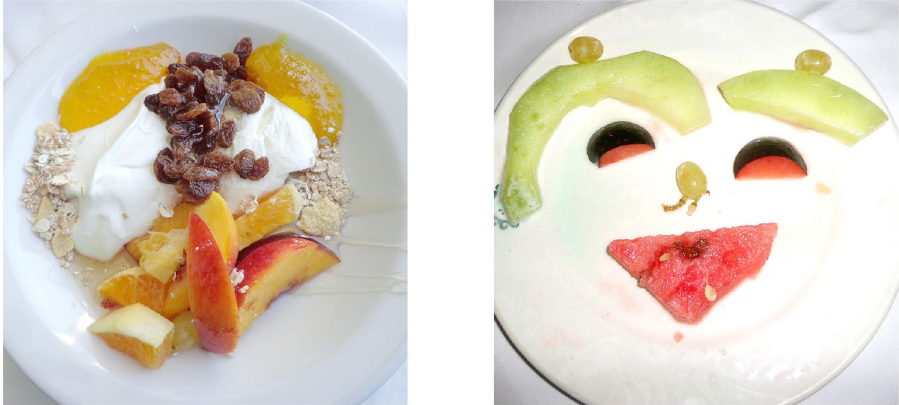
Figure 2. Examples of images from the Face-n-Food task. The least resembling face (left panel) and most resembling face (right panel) images from the Face-n-Food task (from Pavlova MA, Scheffler K, Sokolov AN.